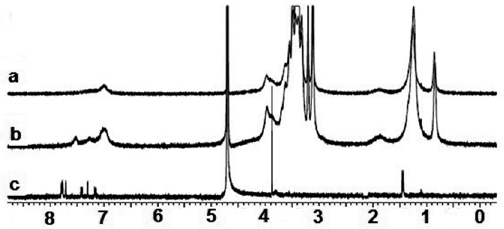
Figure 9. 1 H-NMR spectra of ( a ) 1a , ( b ) the 1a + NAP complex, and ( c ) NAP in D 2 O [1a] = [NAP] = 1.0 × 10 − 4 mol/L in all tests.